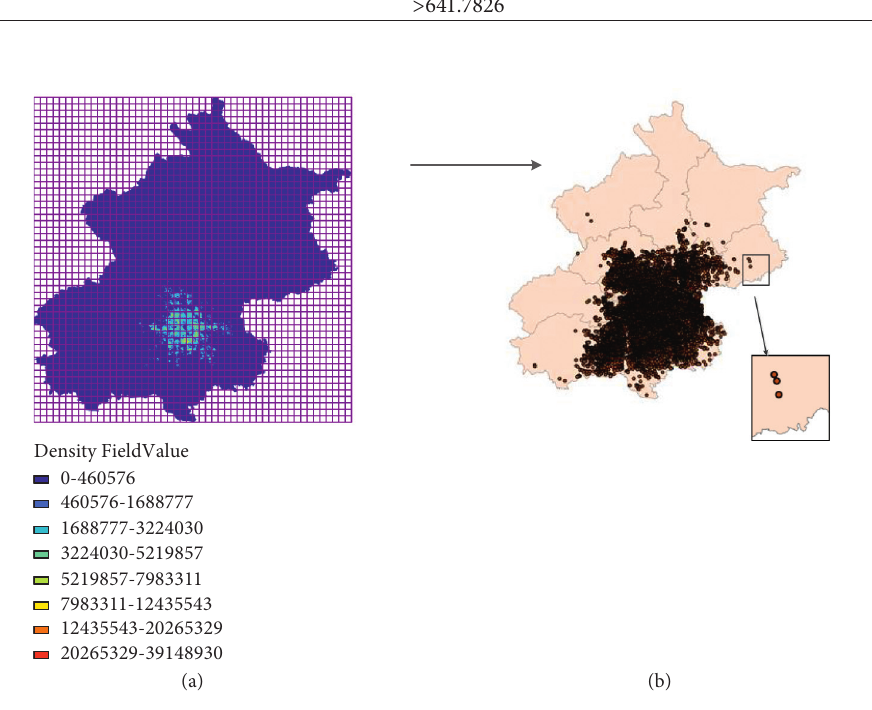
Figure 7: Demonstration density field and